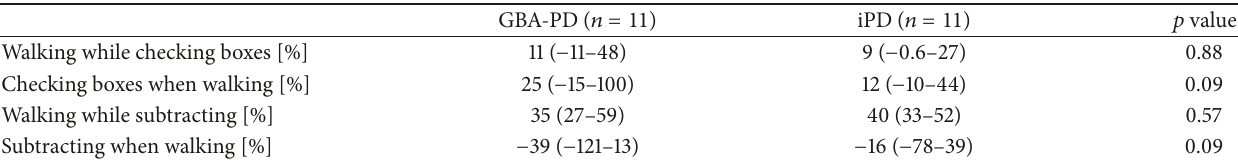
Table 3: Dual-task